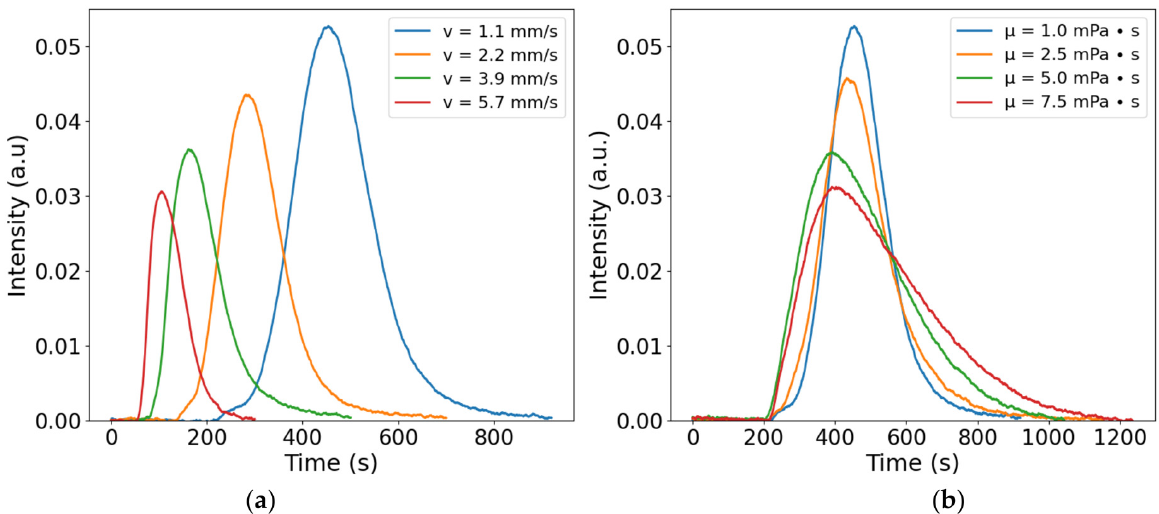
Figure 8. Experimental signals under microfluidic conditions; ( a ) colors are associated with different values of flow velocity using a CDs suspension water only (1.0 mPa s); ( b ) colors are associated with different values of viscosity, while a constant flow velocity of 1.1 mm/s is used.